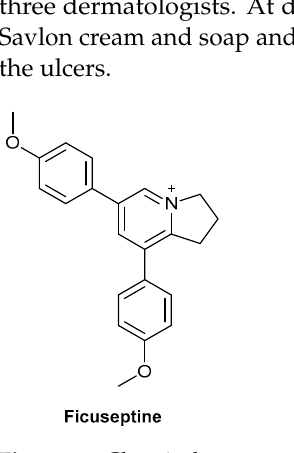
Figure 12. Chemical structure of ficuseptine, an alkaloid present in Ficus septica